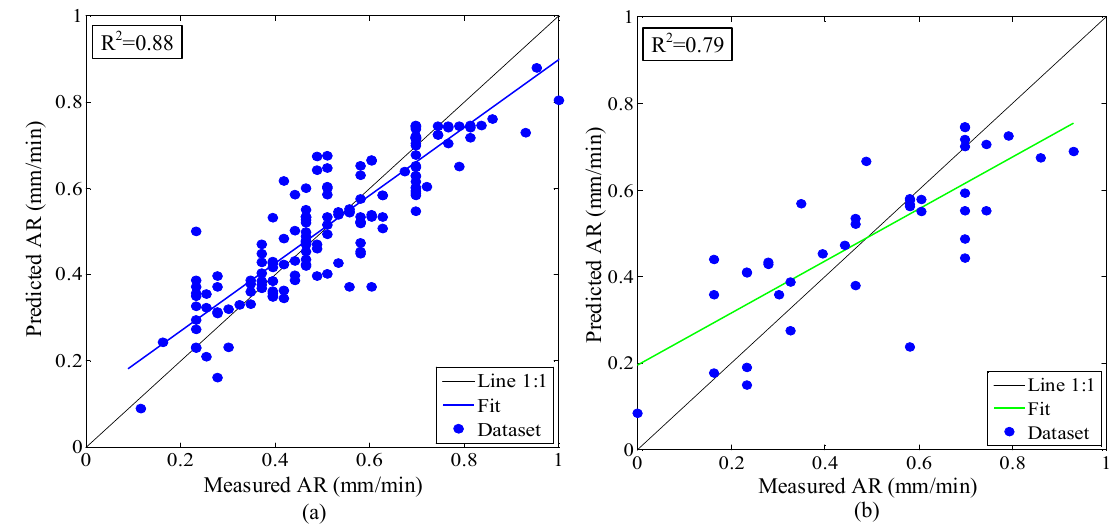
11 of 17 Table 3. ANFIS-GA model’s analytical details. ANFIS parameter type